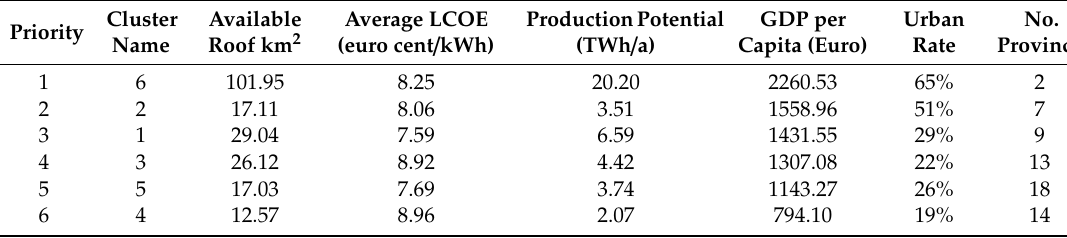
Table 5. Priority groups and their specific